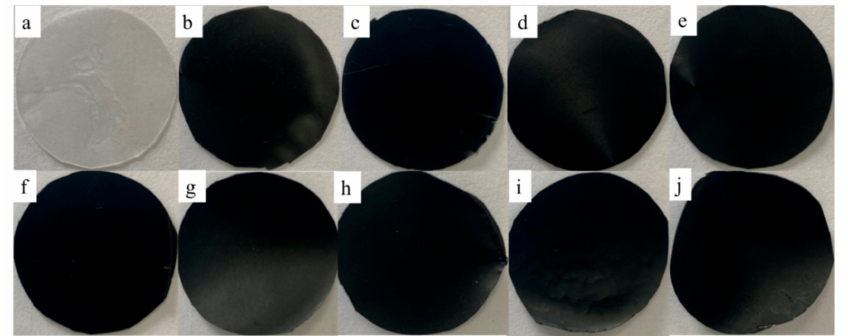
Figure 3. Photos of samples of pure TPU film (melt point of 163 o C, ( a )), and G-TPU composite films with graphene mass content of 0.1 wt% ( b ), 0.3 wt% ( c ), 0.6 wt% ( d ), 1.0 wt% ( e ), 2.0 wt% ( f ), 3.0 wt% ( g ), 4.0 wt% ( h ), 5.0 wt% ( i ), and 7.0 wt% ( j ),